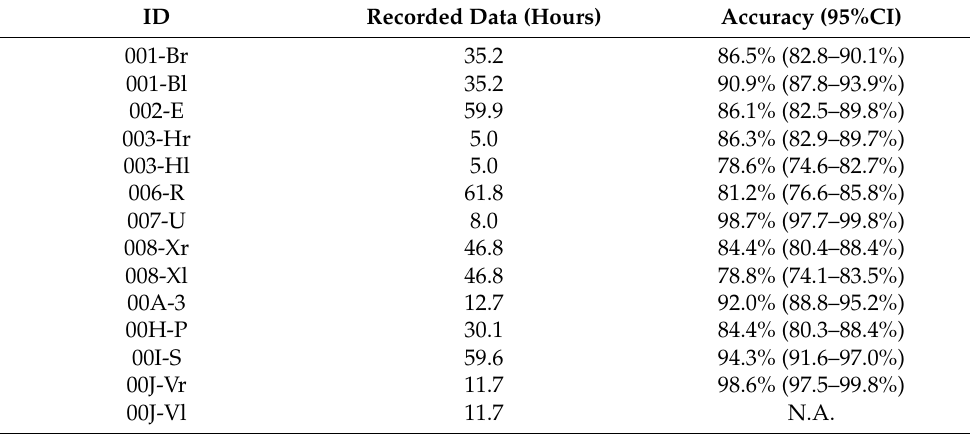
Table 3. Patient ID, recorded hours, and IMA detection accuracy (95%CI) for all assessed biceps brachii muscles. Both arms were assessed in bilateral patients, as indicated by the ‘l’ and ‘r’ letters in the ID. A two-way table was created for each muscle assessed comparing the algorithm-based and the gold-standard classification. The classification accuracy (TP + TN/Total) and its 95% confidence interval were computed and